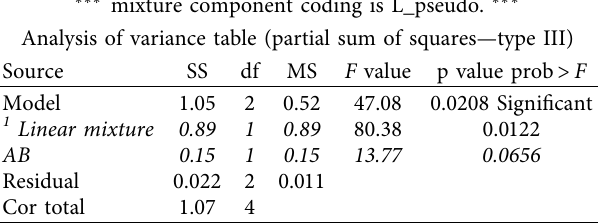
Table 17: ANOVA for the quadratic mixture model for flexural strength